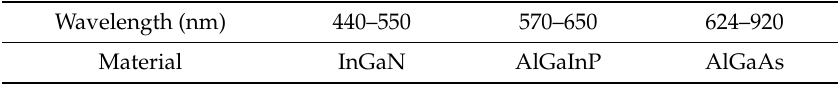
Table 2. Summary of the materials used to design LEDs with di ff erent wavelengths. Figure 4. Optical spectra for a range of commercially available LEDs. Reproduced with permission